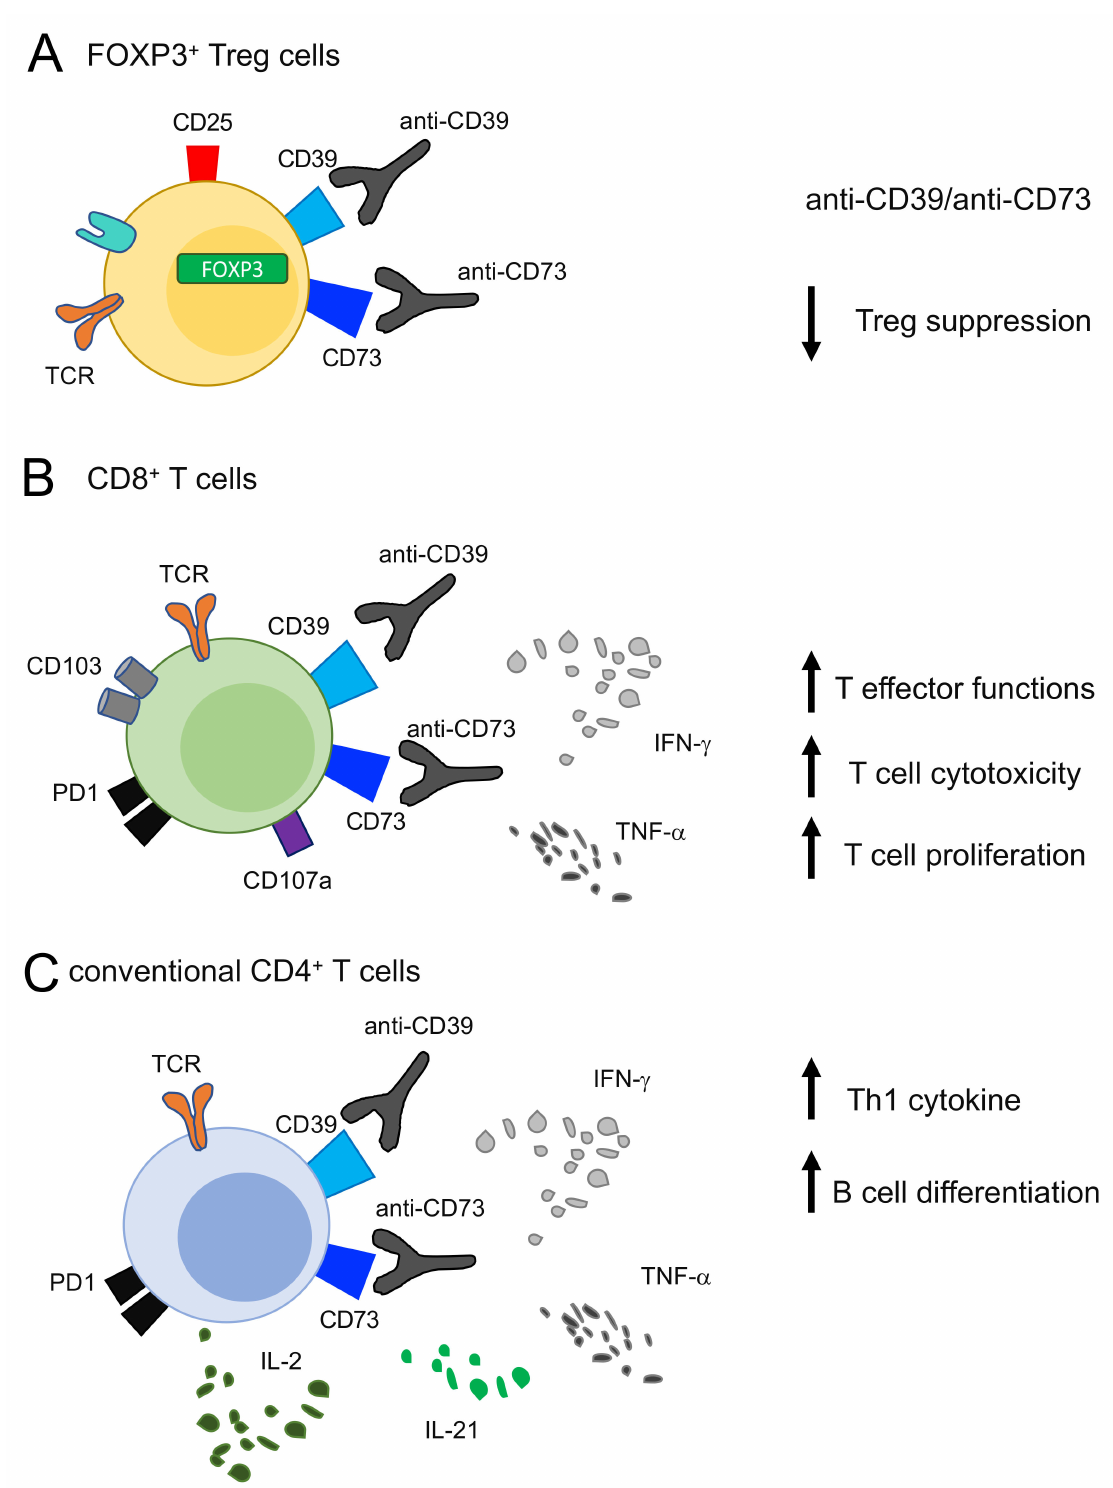
Figure 1. Effects of targeting CD39 on T cells. ( A ) CD39 or CD73 blocking by pharmacological compounds (i.e., POM1 and ARL7156 or small-molecule inhibitors) or by using antibodies in in vivo systems decreases the suppressive activities of FOXP3 + Treg cells. ( B ) Targeting CD39 or CD73 in CD8 T cells effects an increase in effector and cytotoxic T cell functions, mediated by IFN- γ and TNF- α production and CD107a upregulation. ( C ) Targeting CD39 or CD73 in CD4 T cells increases Th1 cytokine (IFN- γ , TNF- α and IL-2) and IL-21 production, which (was recently found to be) is responsible for B cell